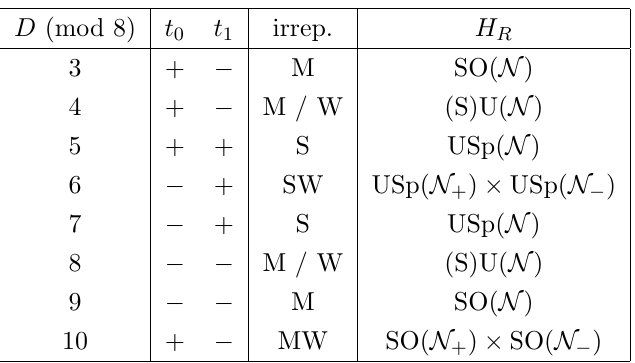
Table 3 . Spinor conventions in various dimensions [54]. t 0 and t 1 are the sign factors introduced in (7.5). \M" stands for Majorana spinors, \S" for symplectic Majorana spinors and \W" for Weyl spinors. In four and eight dimensions one can have either Majorana or Weyl spinors (but not both), while in six and ten dimensions (symplectic) Majorana-Weyl spinors are